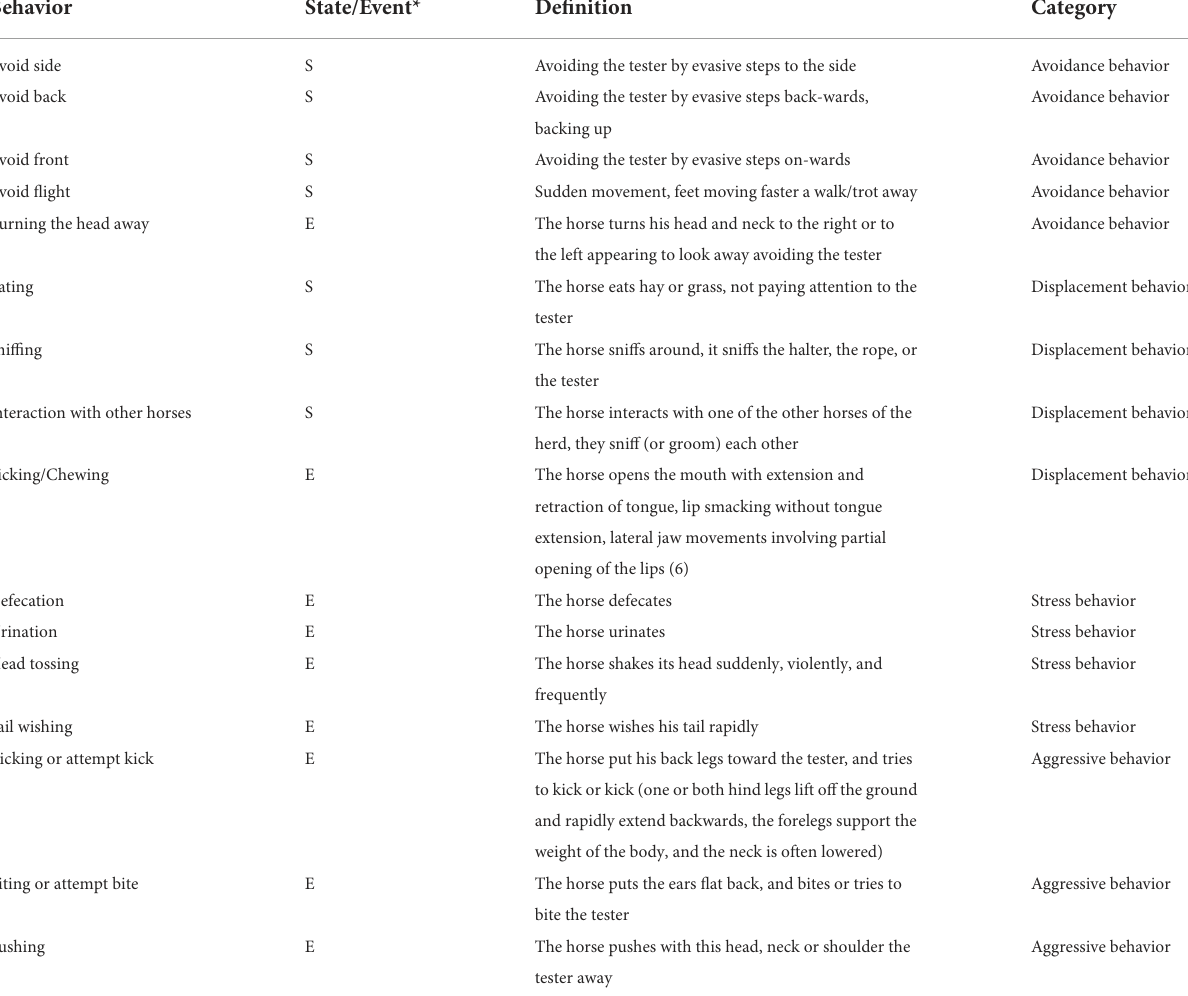
TABLE 1 Ethogram for the evaluation of horse behavior during the broken/unbroken test.